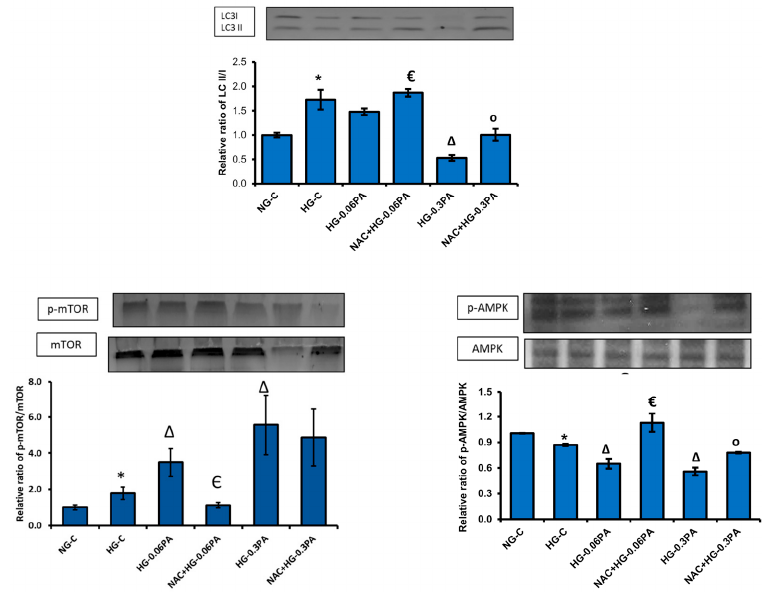
Figure 9. Effect of NAC pre-treatment on the expression of autophagy and cell signaling markers in high glucose/high palmitic acid-treated Rin-5F cells. Total extracts (30 µg protein) from treated cells were separated on 12% SDS-PAGE and transferred onto nitrocellulose paper by Western blotting. LC3, mTOR, and AMPK proteins were detected using specific antibodies against these proteins. Beta-actin was used as loading control. The quantitation of the protein bands is expressed as relative ratios normalized against actin or other specific proteins as appropriate, and histograms are expressed as mean +/ − SEM of three experiments. The blots shown are representative of three experiments. Asterisks indicate significant differences (* p ≤ 0.05) relative to untreated control cells under normal glucose conditions, ( Δ p ≤ 0.05) relative to untreated control cells under high glucose conditions, (€ p ≤ 0.05) relative to 0.06 mM palmitic acid in the presence of high glucose, ( ○ p ≤ 0.05) relative to 0.3 mM palmitic acid